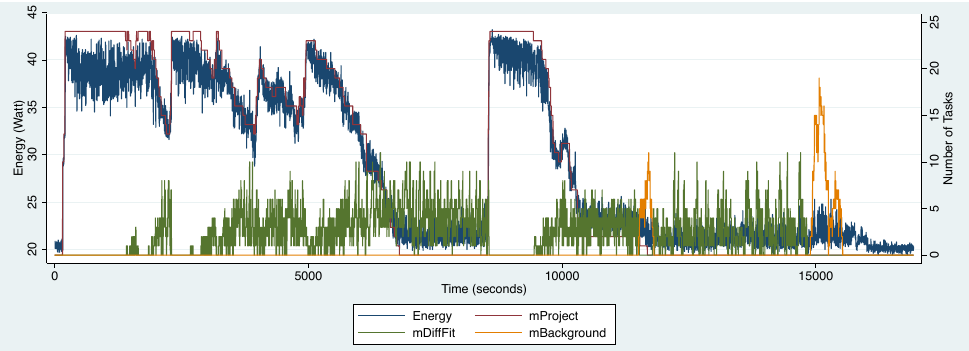
Figure 12. Execution of a Montage 1.5 degree workflow on a 6 node